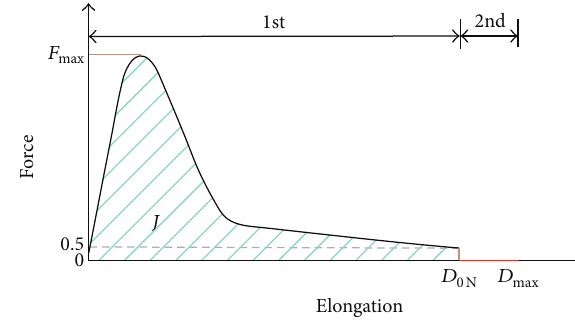
Figure 3: Typical force ductility curve.